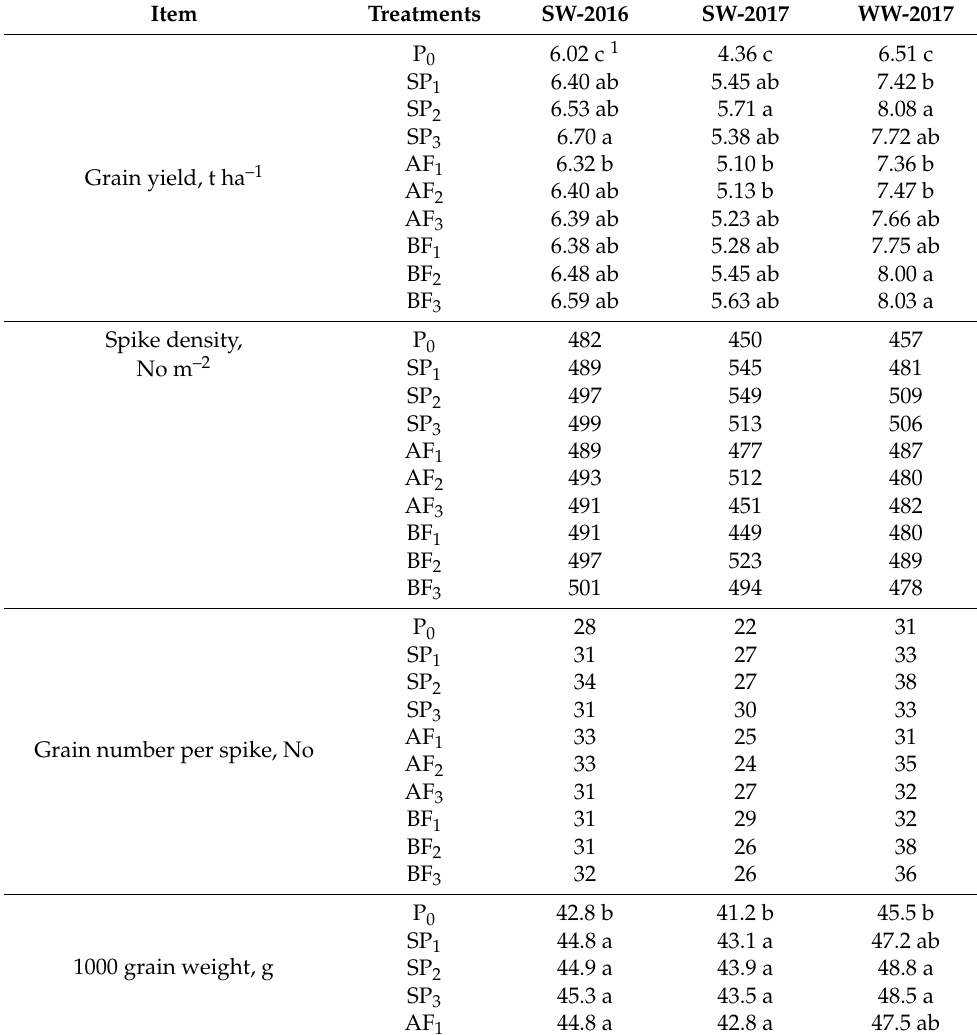
Table 4. Wheat grain yield and its components. Item